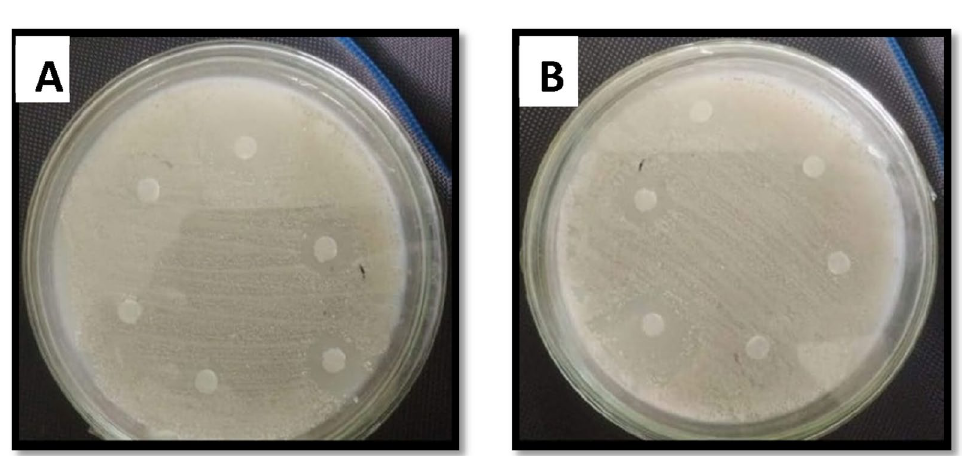
Figure 6. Antibacterial activity of F. cretica (A) Nanoparticles (B) Crude